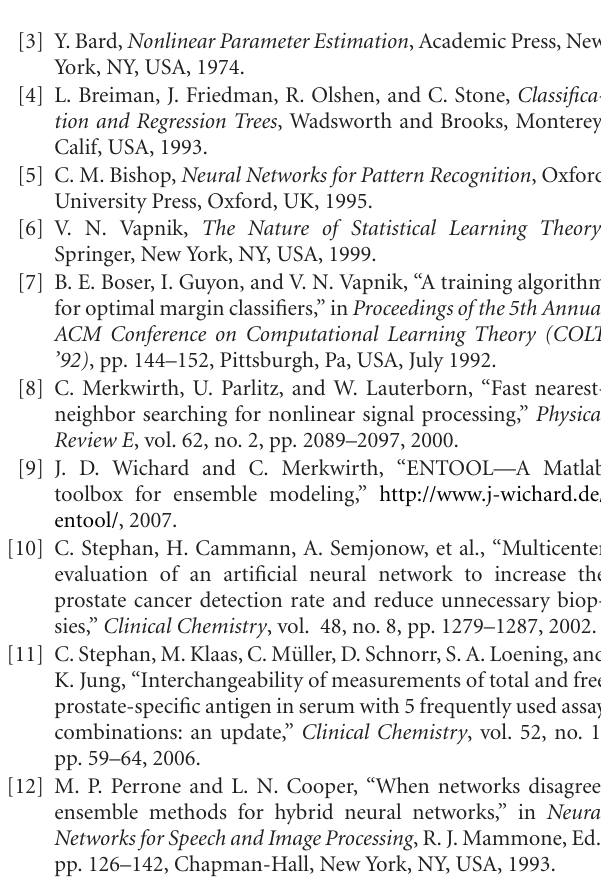
Table 3: The average performance of several classifier ensembles with respect to the validation set which was initially removed and never included in model training. We show the mean and the standard deviation values from 20 independent validation runs wherein the training data was balanced.